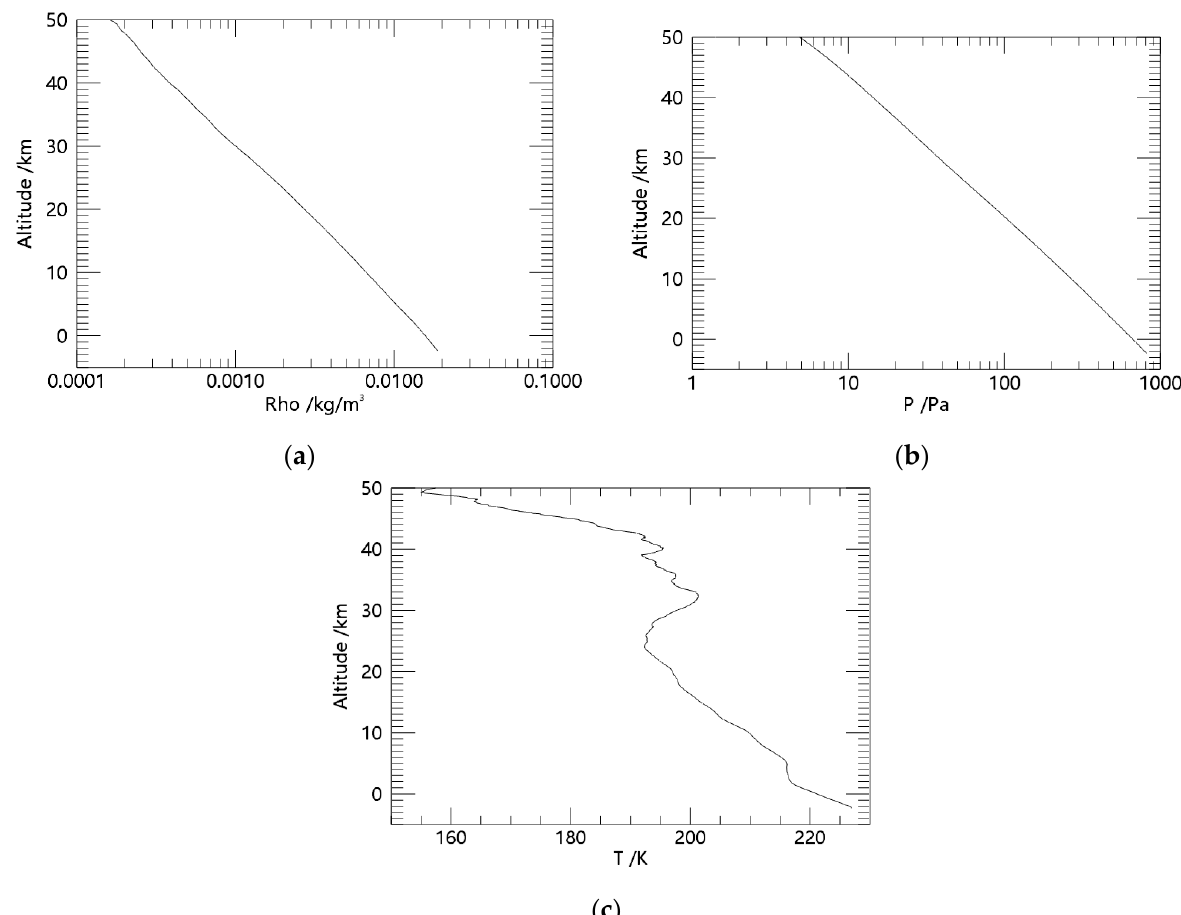
Figure 5. ( a ) Retrieved atmospheric density, ( b ) pressure and ( c ) temperature profiles.